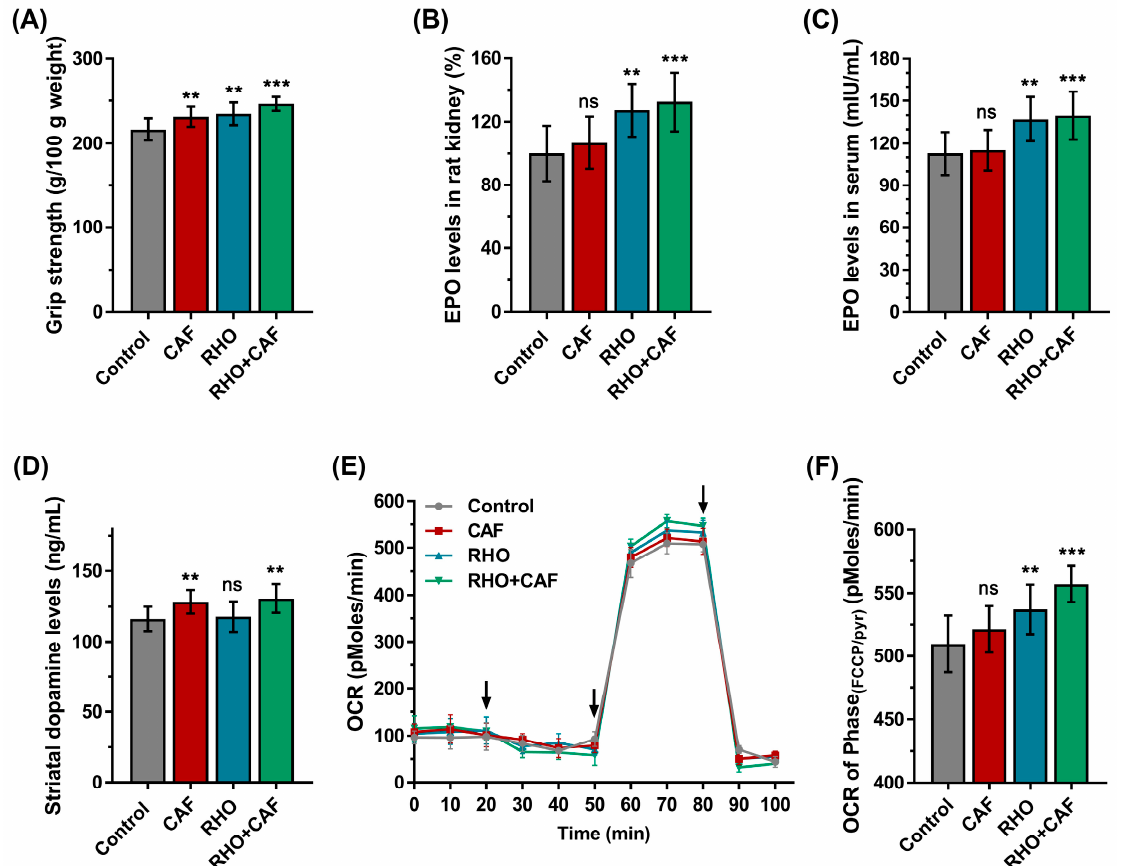
Figure 2. Improvements following supplement treatment in SD rats. ( A ) Forelimb grip strength. ( B ) EPO gene expression in rat kidney. ( C ) Erythropoietin in serum. ( D ) Striatal dopamine. ( E ) Average oxygen consumption rates (OCR, pMoles/min) in single muscle fibers isolated from bilateral gas- trocnemius of rats. Arrows represent successive additions of Oligomycin (1 μ g/mL), FCCP (400 nM) + pyruvate (10 mM), and Antimycin (1 μ M). ( F ) OCR of Phase(FCCP/pyr) in ( E ) for maximal mito- chondrial respiration. All data are presented as mean ± SD (n = 12 × 4 groups = 48 samples). ns indicates no statistical difference, * indicates p < 0.05, ** indicates p < 0.01 and *** indicates p < 0.001 compared with control group.